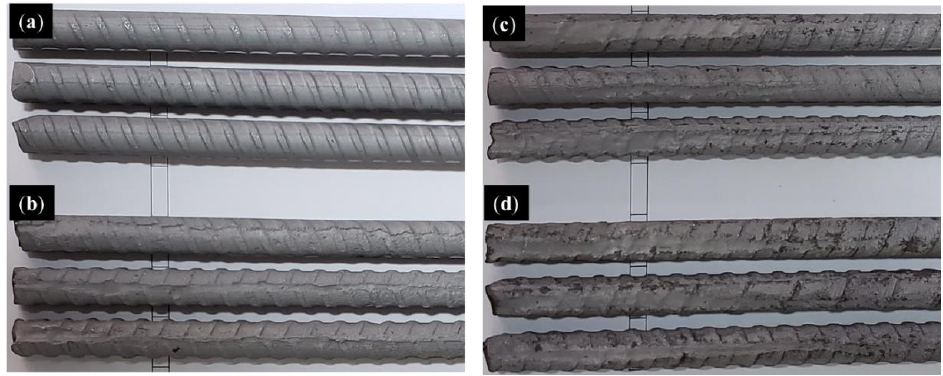
Figure 4. Embedded rebar section loss pattern: ( a ) Ref; ( b ) 0.5 CP; ( c ) 1.0 CP; ( d ) 1.5 CP.